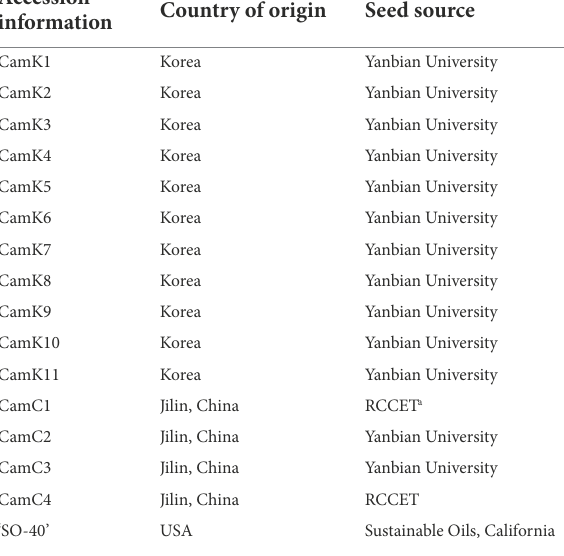
TABLE 1 The origin and description of the 16 Camelina sativa used in this